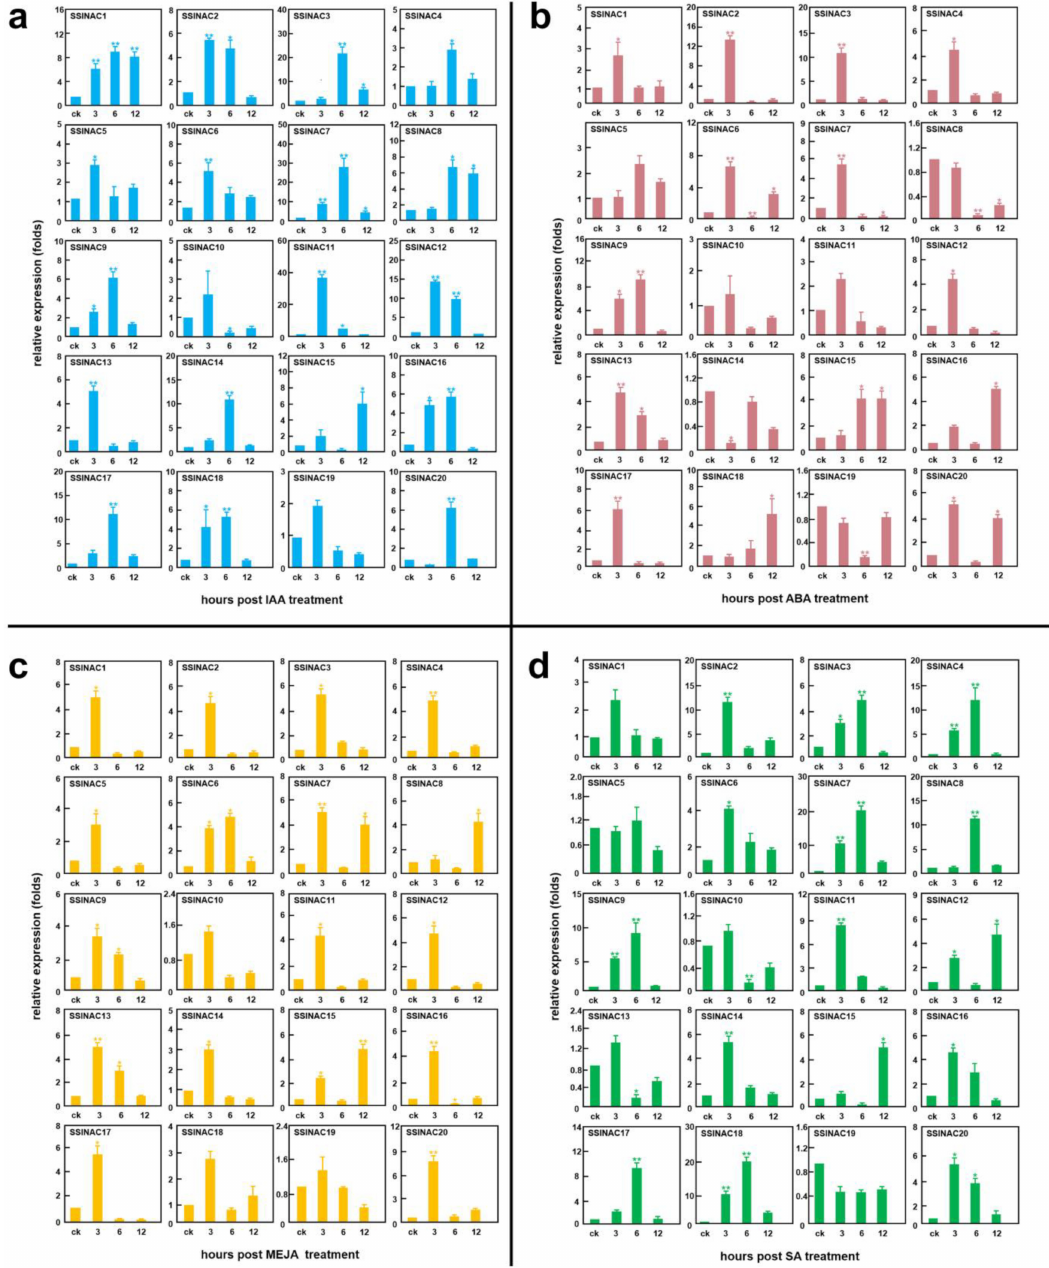
Figure 7. Expression levels of SSlNAC1–20 under different phytohormone treatments at different times (3, 6, and 12 h): ( a ) IAA (indole-3-acetic acid) treatment; ( b ) ABA (abscisic acid) treatment; ( c ) MEJA (methyl jasmonic acid) treatment; ( d ) SA (salicylic acid) treatment. The 2 − ∆∆ Ct method was used to calculate the expression fold for each SSlNAC gene. Data are the mean ± standard errors (SD) from three independent biological replicates. Error bars indicate the standard error. An asterisk (*) represents a significant difference (* p < 0.05, ** p <